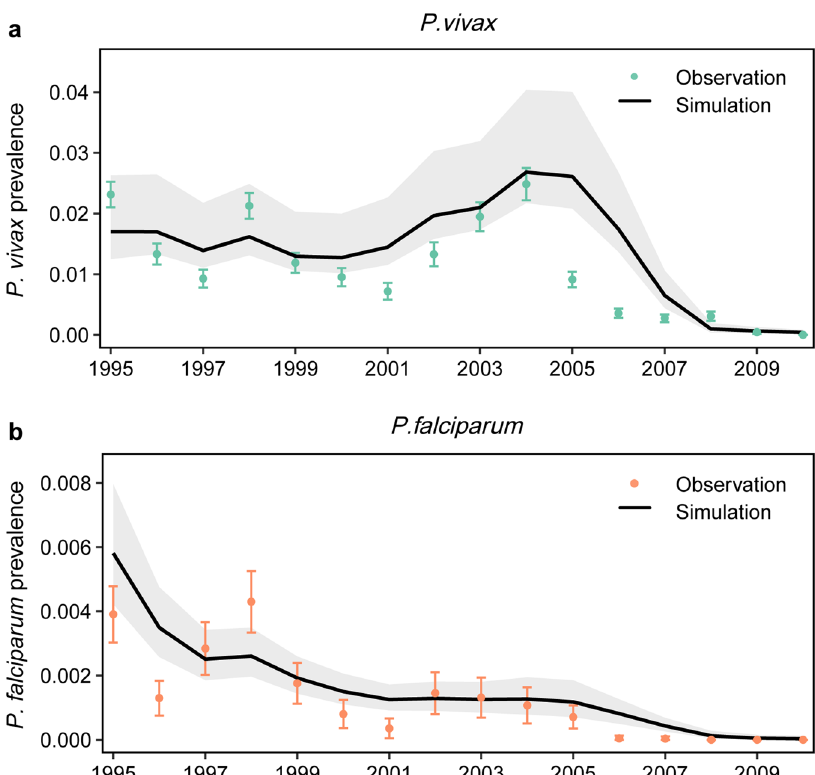
Fig. 3 Malaria prevalence in humans. a P. vivax and b P. falciparum . The annual malaria prevalence was obtained from mass blood examinations. The observed data are plotted as green ( P. vivax ) and orange ( P. falciparum ) points with 95% con fi dence interval. The solid lines correspond to the malaria prevalence in humans estimated by epidemic model, and the grey areas correspond to pointwise 95% credible